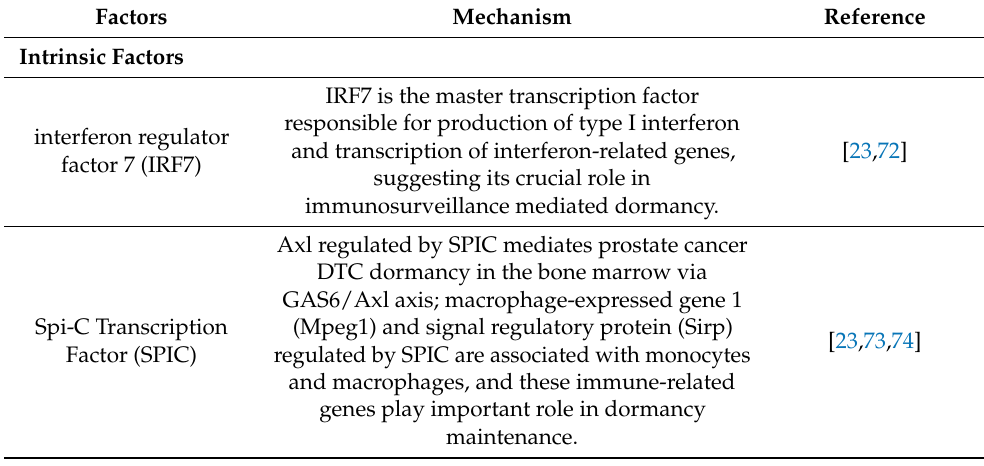
Table 2. Intracellular and extracellular factors leading to cancer cell